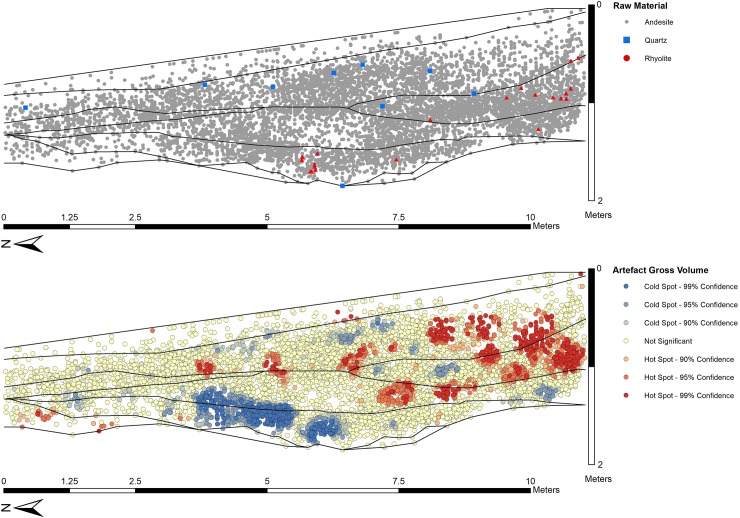
The vertical distribution of artefacts in the Whalen Trench by material, size, and density.Layers were drawn by the present authors and correspond to those in the 2014 excavation. Only the upper part of Layer F containing artefacts is shown. Note that the vertical scale is exaggerated.